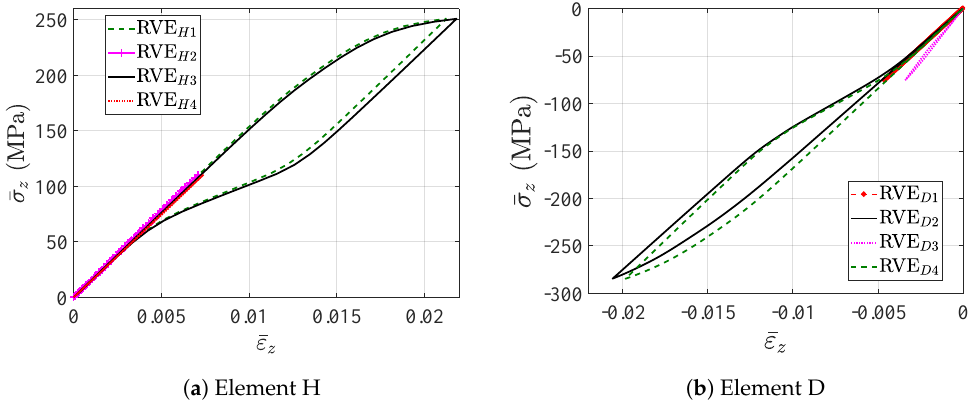
Figure 18. The stress-strain relations on the macroscopic integration points with ξ =